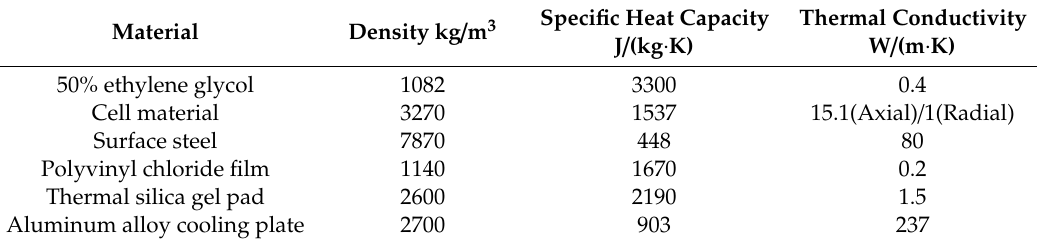
Table 3. Physical properties of the